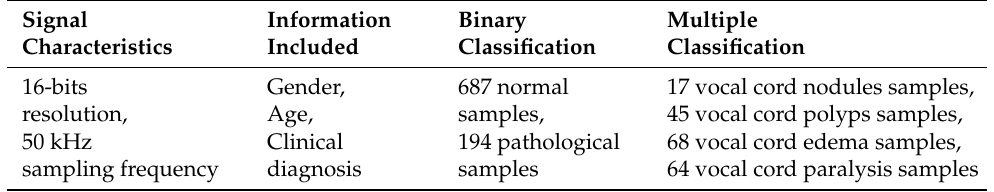
Table 2. The primary information in the SVD